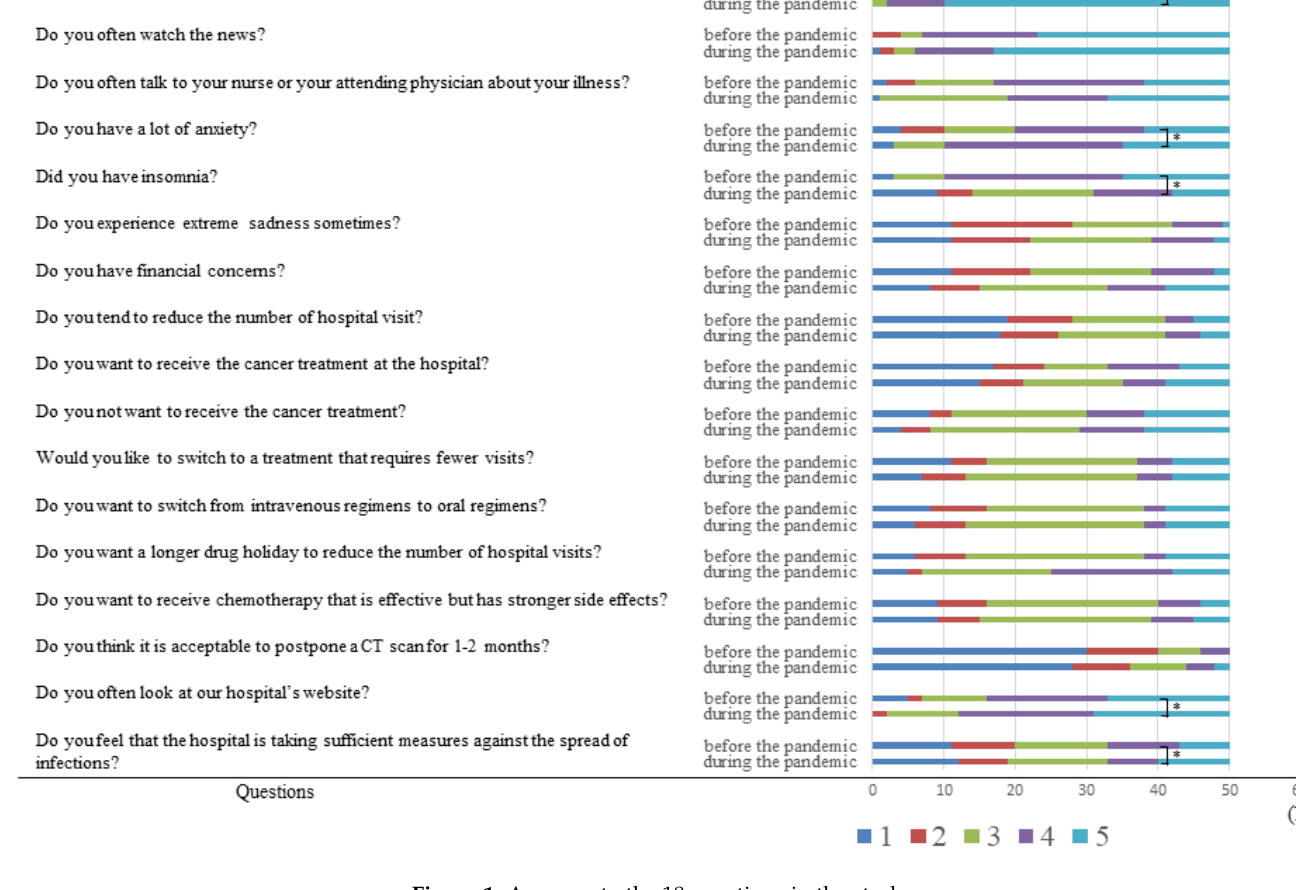
Figure 1. Answers to the 18 questions in the study. Table 2. The distribution of the overall responses to the questions.